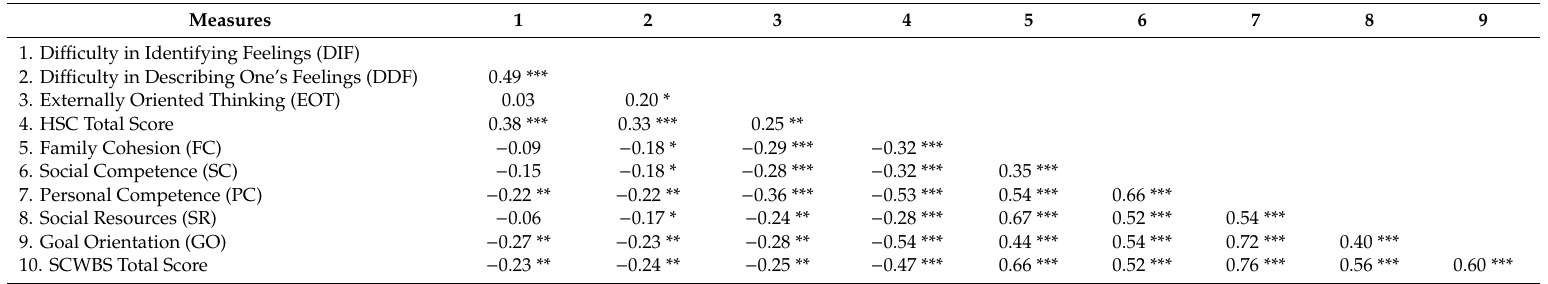
Table 2. Correlations between all measures at the pre-test.